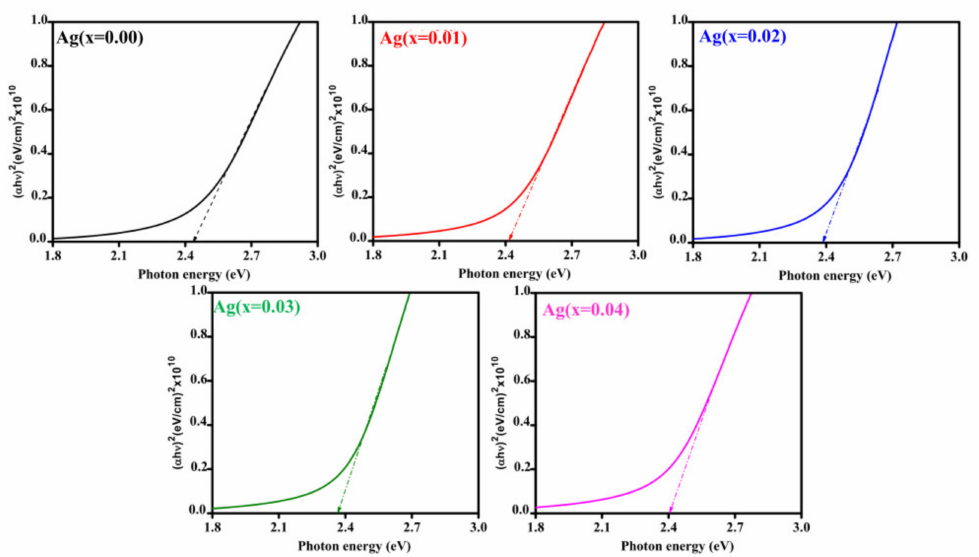
Figure 3. Optical bandgap spectra of pure and Ag-doped CdO thin films. Table 2. Optical properties of Cd 1–x Ag x O thin films. Ag Doping Level